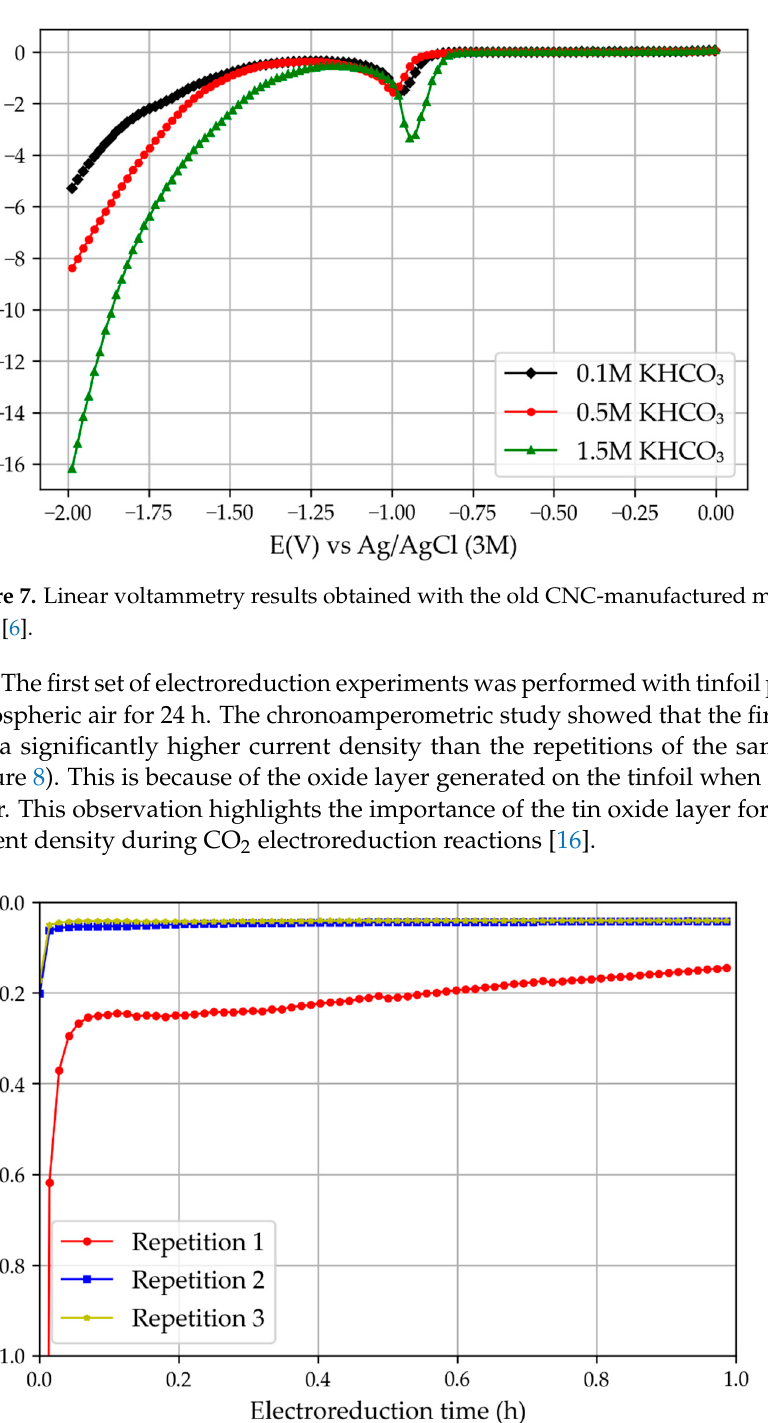
Figure 6. Cyclic voltammetry results obtained with the 3D printed reactor.